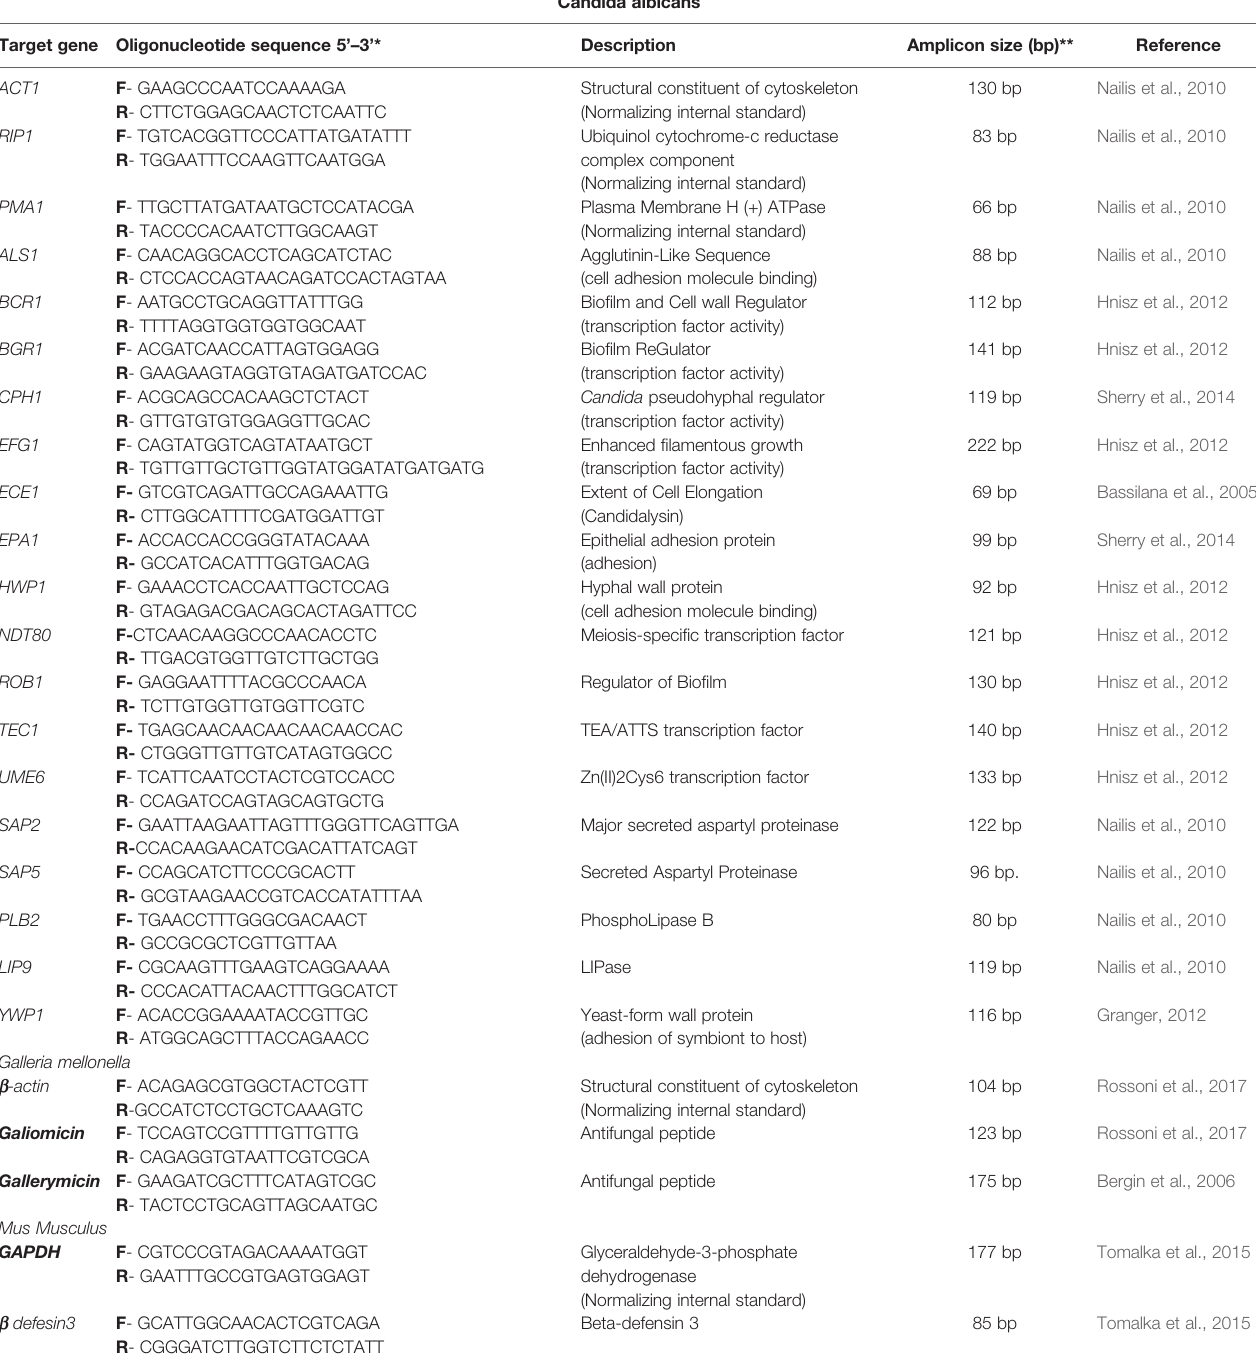
Candida albicans